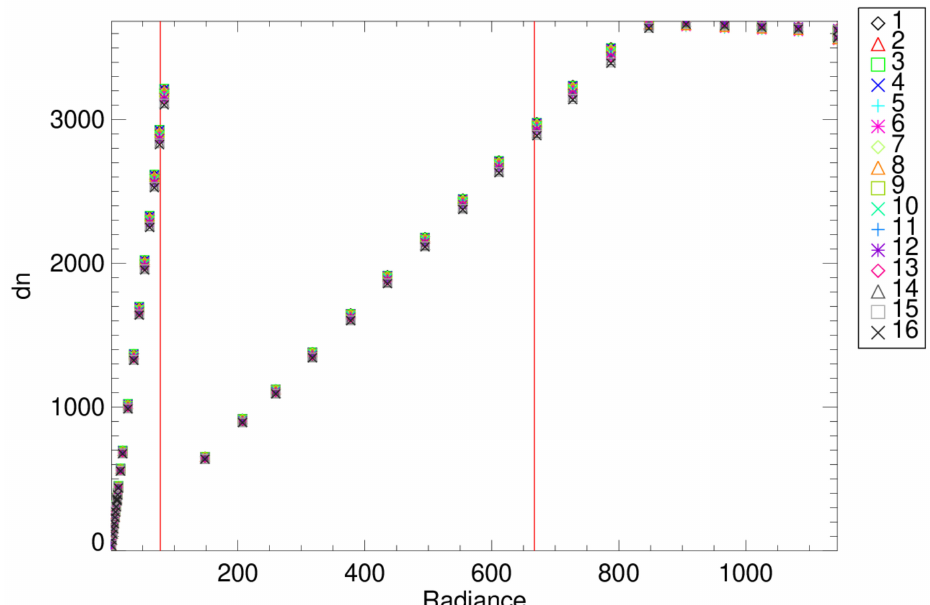
Figure 4. Band M4 dynamic range measurements for all detectors, legend in the upper right, for HAM side A. The points to the left of the first vertical line are high gain measurements. The band switches to low gain after a radiance of ~100. The first and second vertical red lines are for high and low gain Lmax, respectively. The y-axis is offset subtracted VIIRS response, and the x-axis is the SIS100 radiance during the measurement.